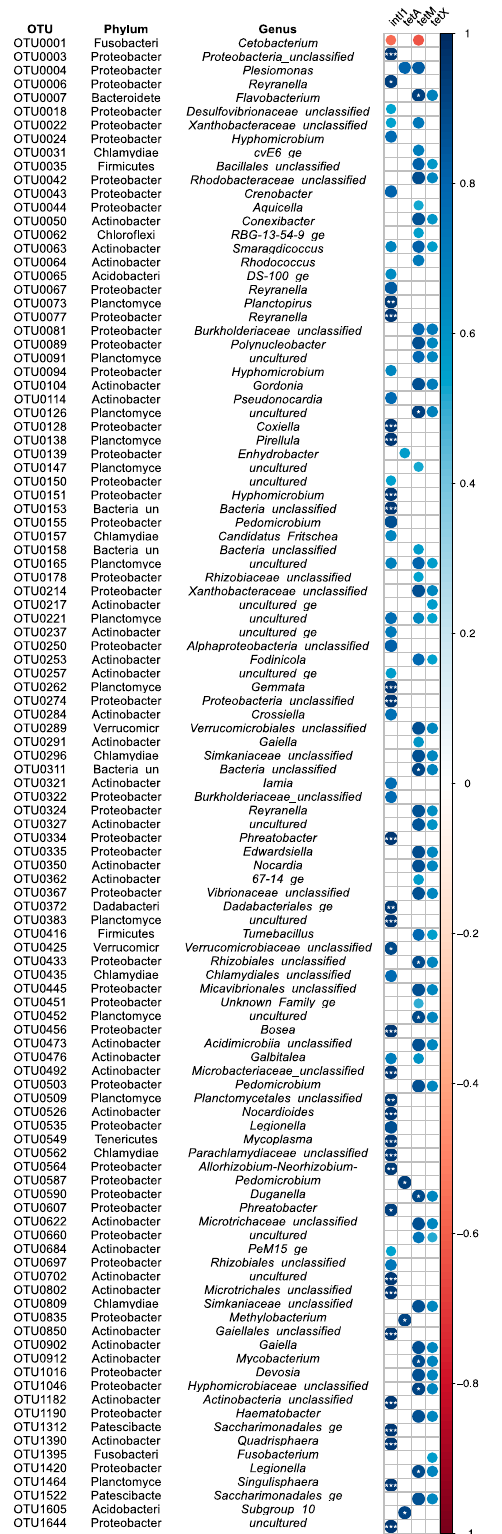
Figure 7. Correlation analysis between antimicrobial resistance gene abundance and operational taxonomic unit (OTU). Circle colour indicates negative or positive Pearson’s correlation coefficient according to colour scale. * denotes significance level e.g., * p < 0.05; ** p < 0.001; *** p < 0.0001.